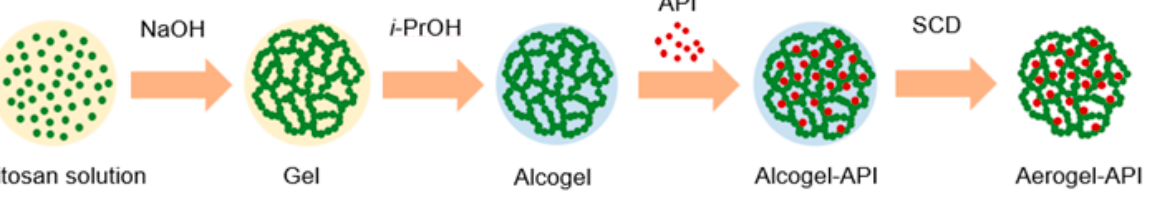
Figure 2. Process of obtaining chitosan-based aerogel particles impregnated with